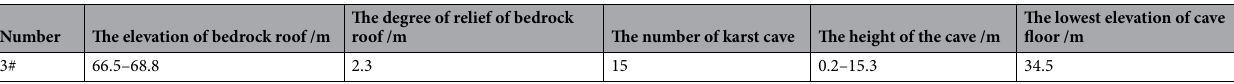
Table 2. Karst characteristics of pier 3#.